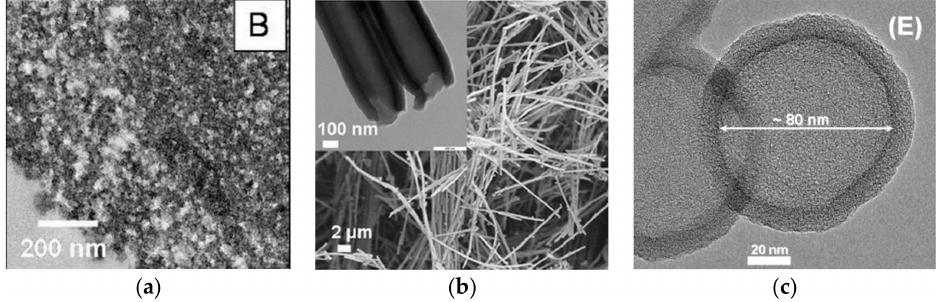
Figure 11. TEM images of porous biochar prepared via templating methods: ( a ) mesoporous microspheres, reprinted with permission from Reference [102]. Copyright (2007) John Wiley and Sons; ( b ) tubular structures, reprinted with permission from Reference [104]. Copyright (2010) American Chemical Society; ( c ) hollow nanospheres, reprinted with permission from Reference [105]. Copyright (2010) American Chemical